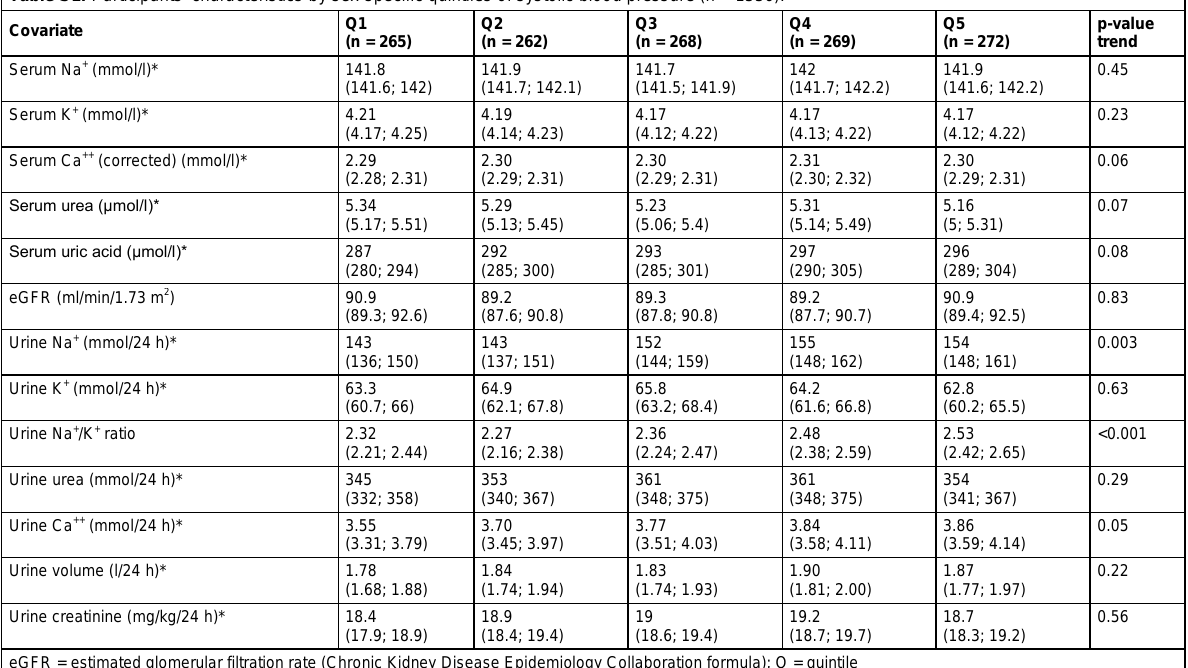
eGFR = estimated glomerular filtration rate (Chronic Kidney Disease Epidemiology Collaboration formula); Q = quintile Data are adjusted means and 95% confidence limits. Means are adjusted for age, sex, body mass index and linguistic region.